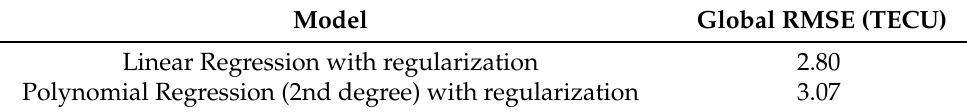
Figure 18. RMSE for Polynomial Regression. Table 2. Global RMSE for regularized